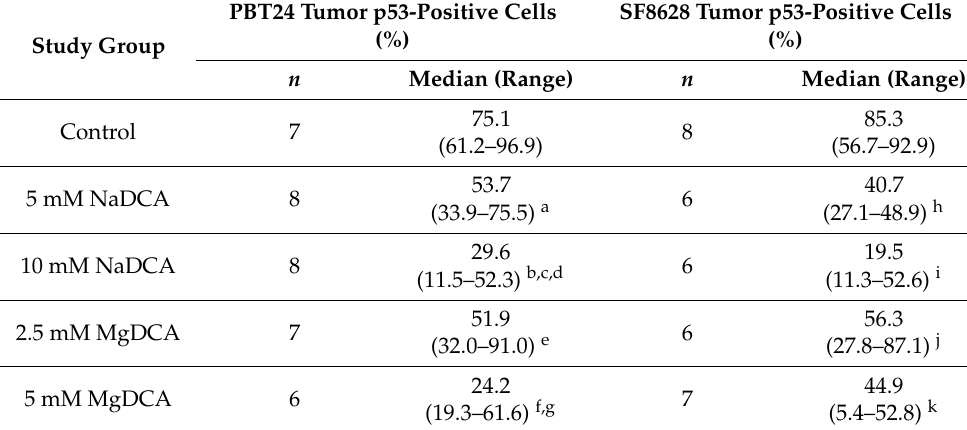
Table 4. The p53-positive cells percentage in PBT24 and SF8628 tumors